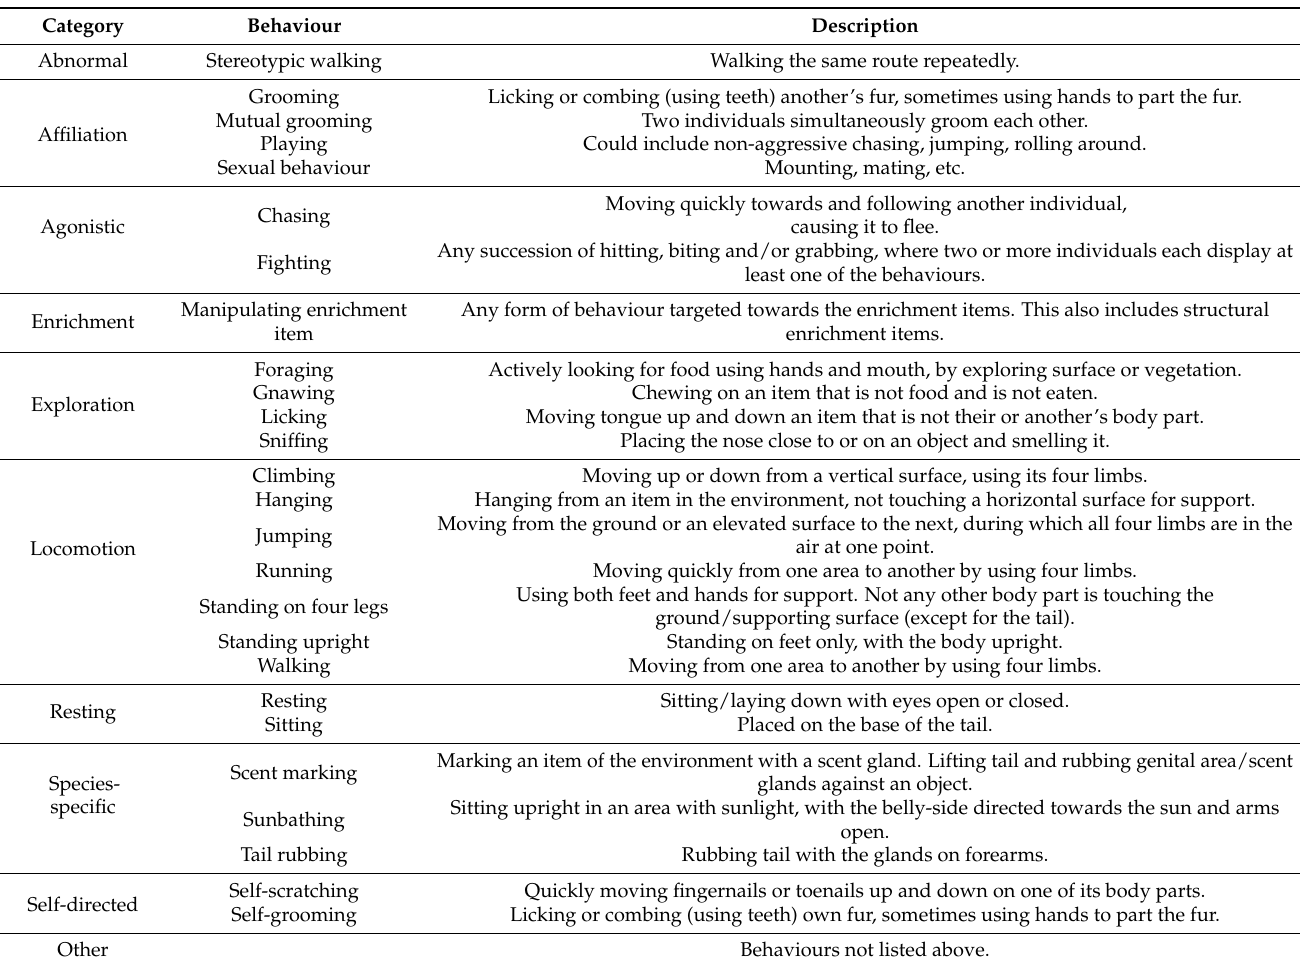
Table 1. Behavioural ethogram used during the study, with behavioural categories, its included behaviours and their description. Category